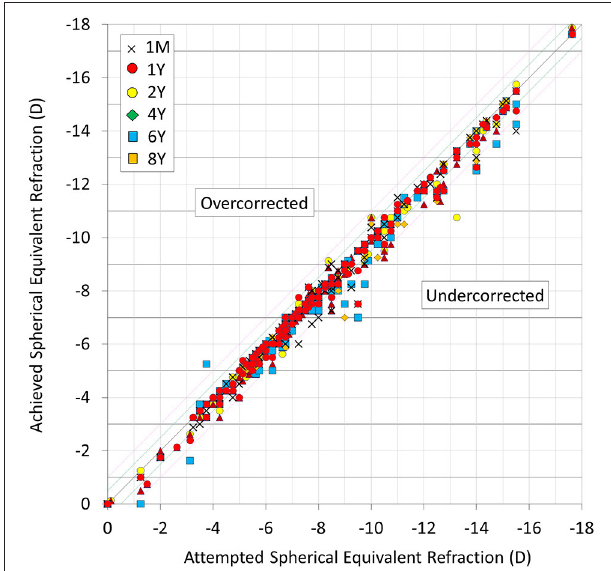
FIGURE 3 | Scatter plot of attempted vs. achieved correction (spherical equivalent) after hole implantable collamer lens (EVO-ICL) implantation.